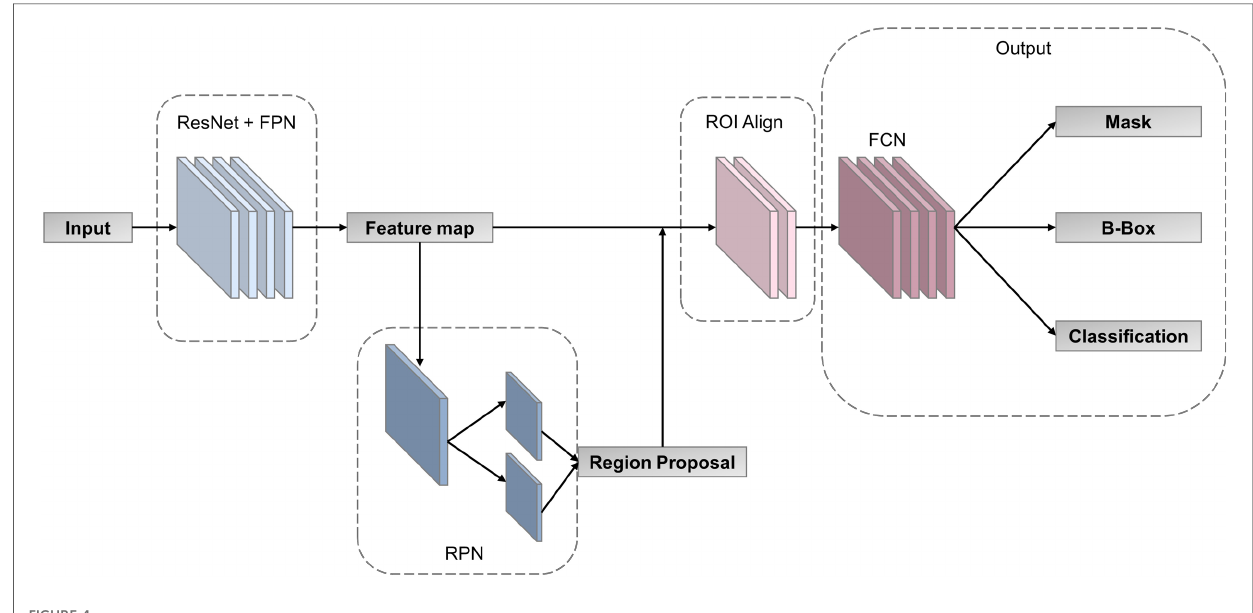
FIGURE 4 Structure of our multi-task deep learning